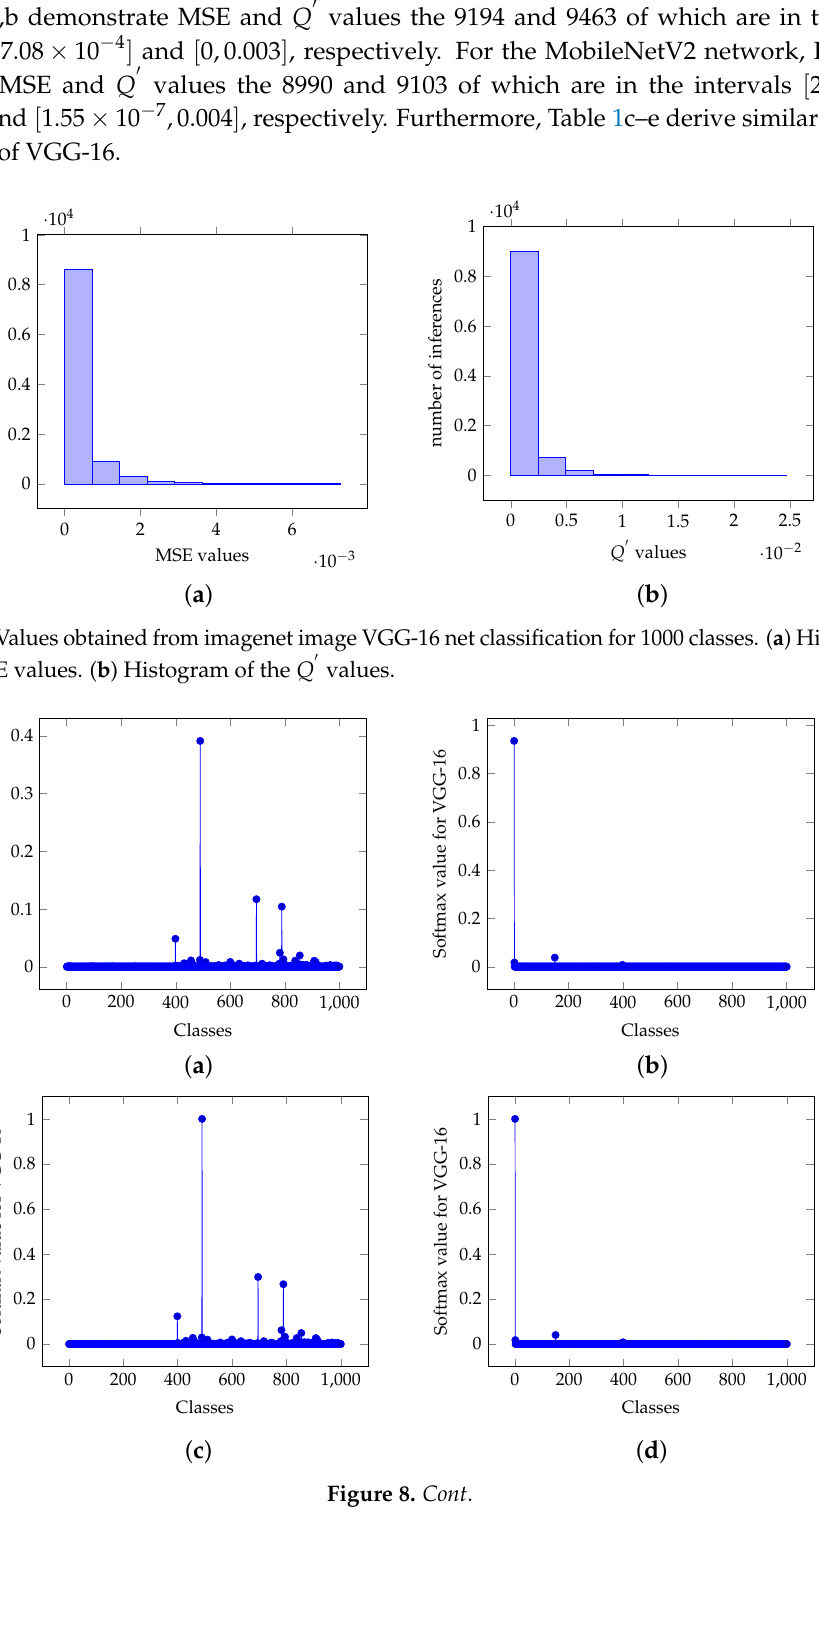
Figure 9. Values obtained from imagenet image inceptionV3 net classification for 1000 classes.